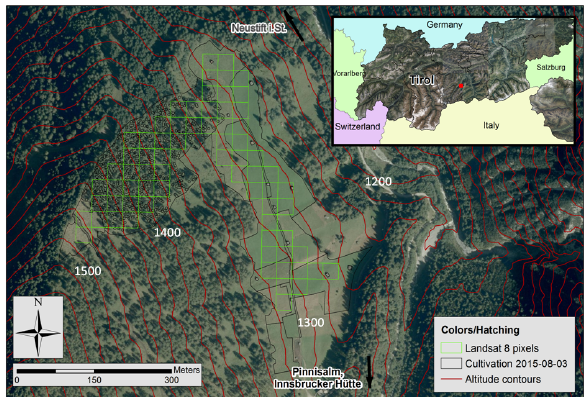
Figure 1: The Pinnis Valley test site (black polygon outlines).